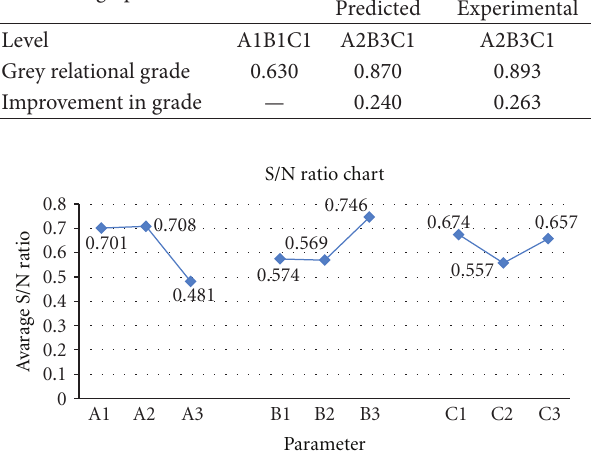
F 5: Main effects plot for S/N ratios